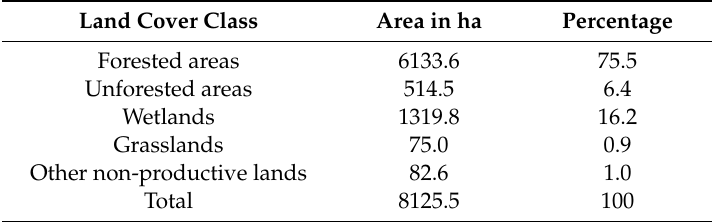
Table 1. Distribution of the areas of the AOIs across land cover categories according to the forest inventory